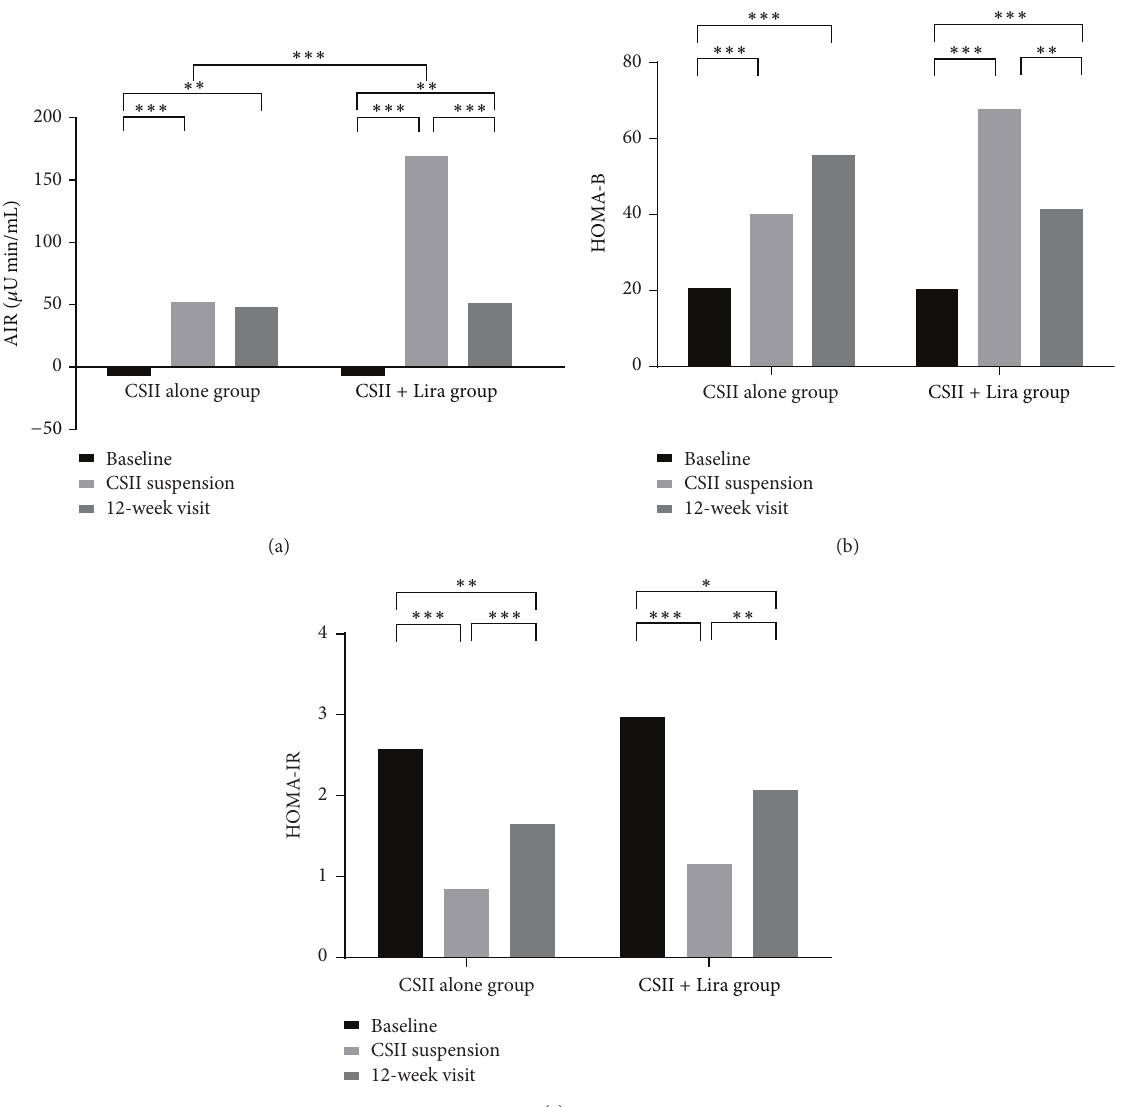
similar to CSII alone group (55.65 (56.27) , 𝑃 = 0.110